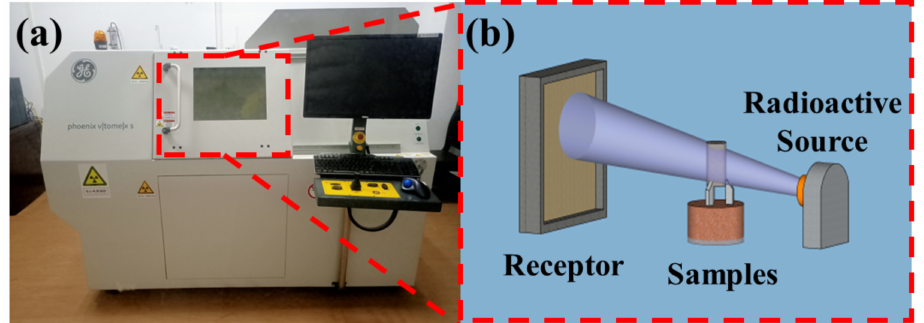
Figure 2. ( a ) Entity devices and ( b ) schematic diagram of